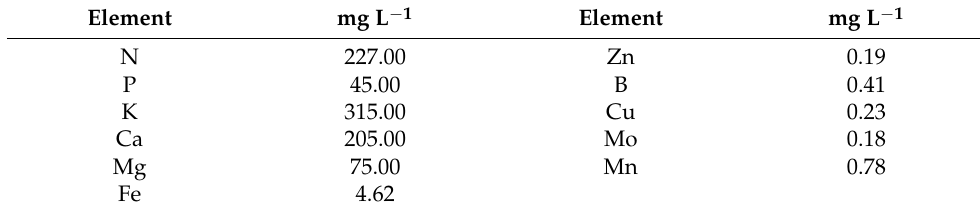
Table 2. Concentrations of mineral nutrients in 100% mineral nutrition